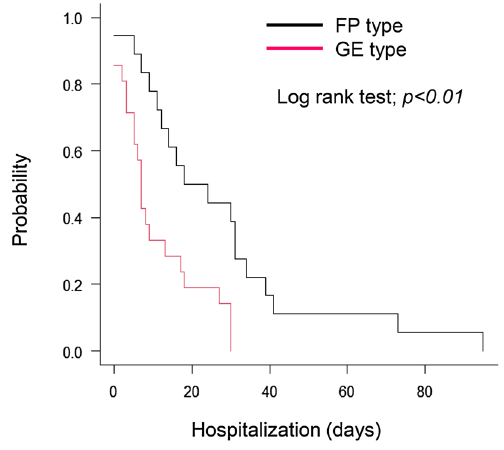
Figure 2. Kaplan–Meier curve for hospitalization periods. Comparison of gastroenteritis (GE) type and fever predominant (FP) type. Campylobacter bacteremia showed that hospitalization days were significantly longer in the FP type ( P <